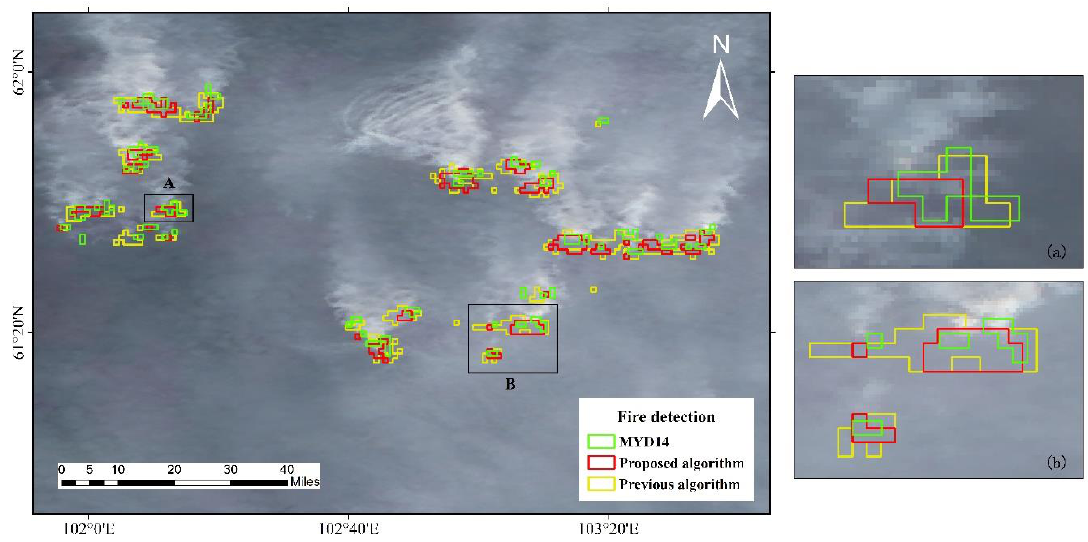
Figure 7. Comparison with previous algorithm of 5 August 2019 fire results in Siberia, Russia. On the right ( a , b ) are partial enlargements of regions A and B on the left, respectively.